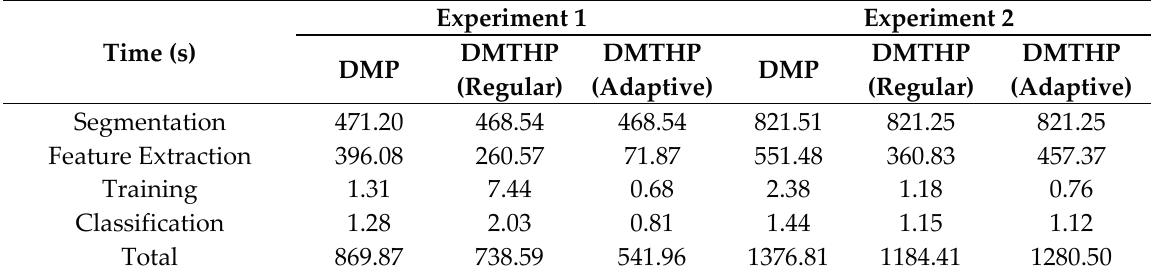
Table 6. Running time of the different steps of the classification. DMP, differential morphological